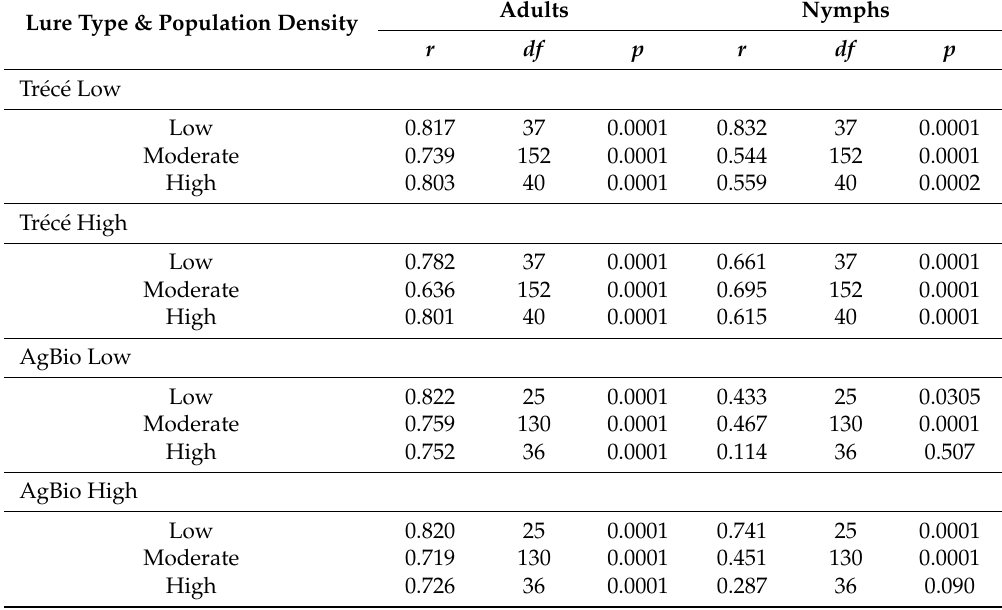
Table 2. Pearson correlation coefficients ( α = 0.05) between captures of H. halys in pyramid traps compared with clear sticky cards under low, moderate, and high relative population densities in 2016. Lure Type & Population